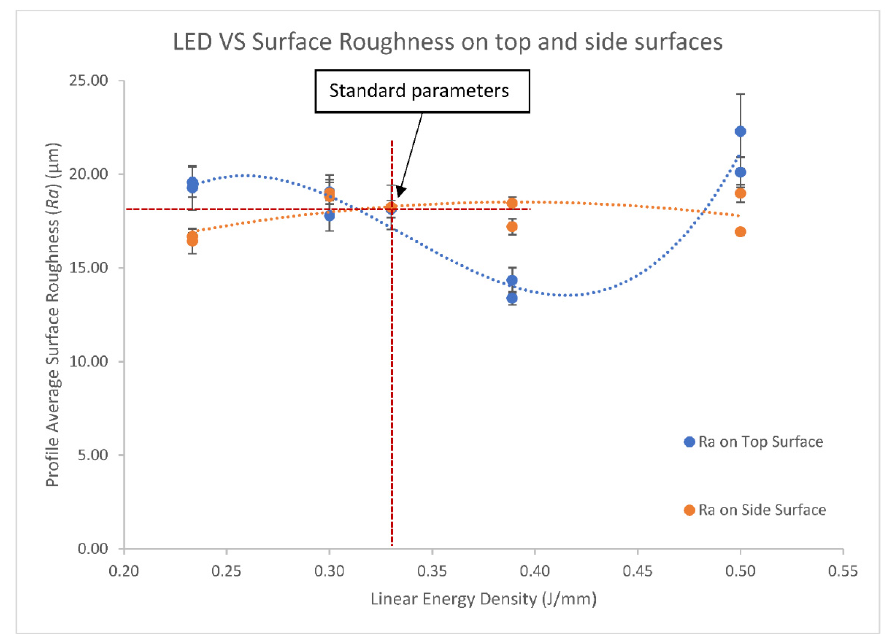
Figure 7. Measured surface roughness R a on the top and side